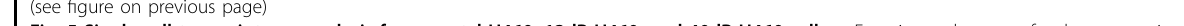
Fig. 5 Single-cell transcriptome analysis for parental H460, 13dR-H460, and 40dR-H460 cells. a Experimental process for the preparation of 13dR-H460 and 40dR-H460 cells employed for single-cell transcriptome analysis. b UMAP plots for cluster designation based on an integrated single- cell transcriptome. Eight clusters (1 to 8) were derived from the integrated single-cell transcriptome with SEURAT. c UMAP plots for each sample from the integrated single-cell transcriptome. Data from H460, 13dR-H460, and 40dR-H460 are indicated by yellow, sky blue, and orange dots, respectively. H460-, 13dR-H460-, and 40dR-H460-predominant clusters are indicated by yellow, sky blue, and orange circles, respectively. Clonal heterogeneity did not change in 13dR-H460 compared to parental H460 cells; only the relative fractions changed. d Barplots representing the relative fractions of the three cell types in each cluster. e Model for epigenetically driven drug resistance based on the R-cancer system. Drug treatment of cells with short- term resistance or epigenetically transitional cells induces medium-term drug resistance. f Epigenetics-driven drug resistance depending on synchronized or unsynchronized epigenetic cycles. a With random epigenetic cycles, each cancer cell may undergo epigenetic transitions randomly, and drug treatment for period A or period B would yield a similar level of drug resistance. b With epigenetic cycles synchronized by the withdrawal of stem cell media, as in our R-cancer model, cancer cells may exhibit an epigenetically transitional status at the same time. Therefore, drug treatment for period A or period B would have different results depending on the amount of short-term drug-resistant cells. The Y-axis represents individual cells; the X-axis represents time progression with epigenetic